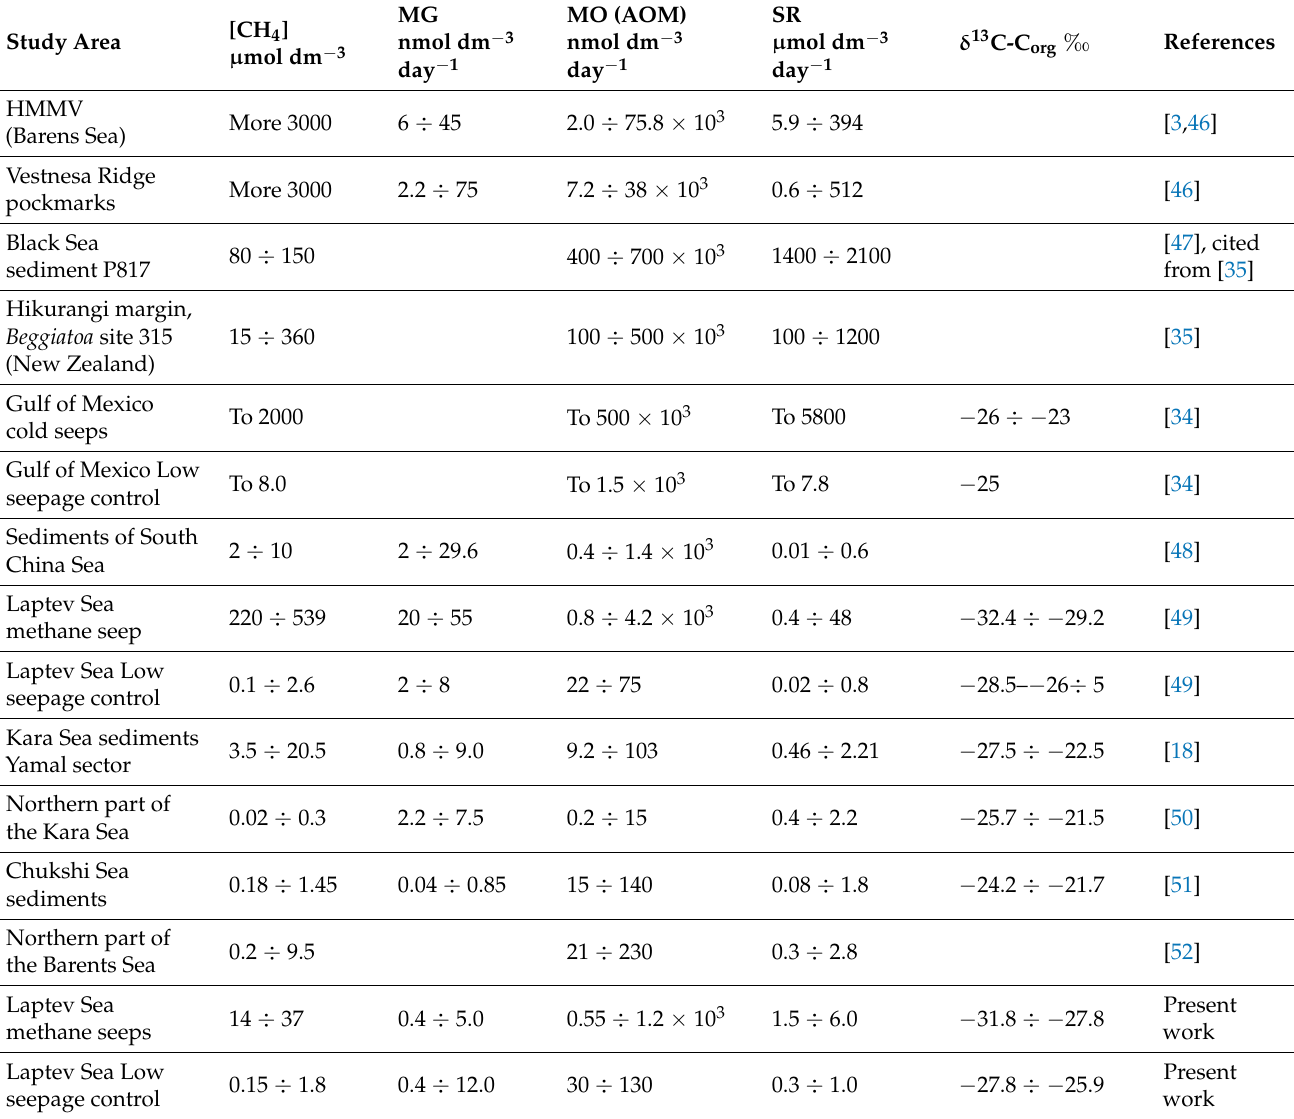
Table 4. Comparison of Laptev Sea methane seeps to previously described methane-containing marine sediments, cold methane seeps, and the sediments with background methane